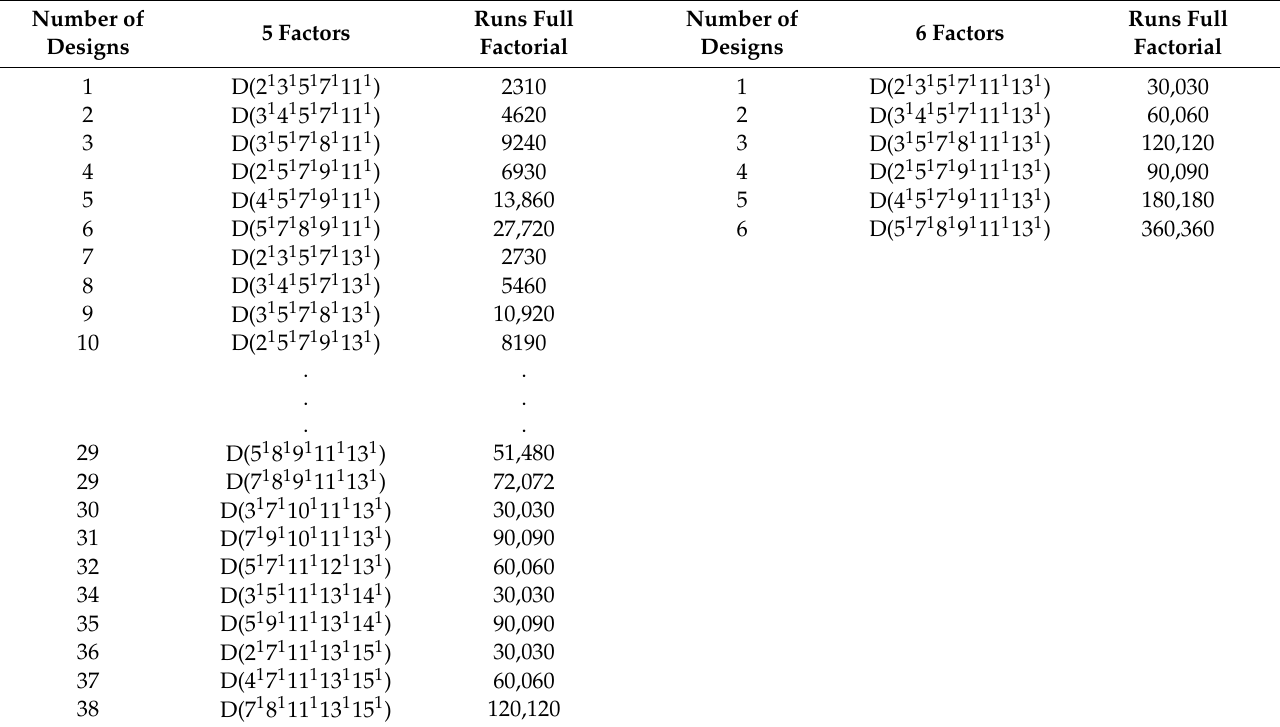
Table 2. Examples of pure asymmetrical arrays with 5 to 6